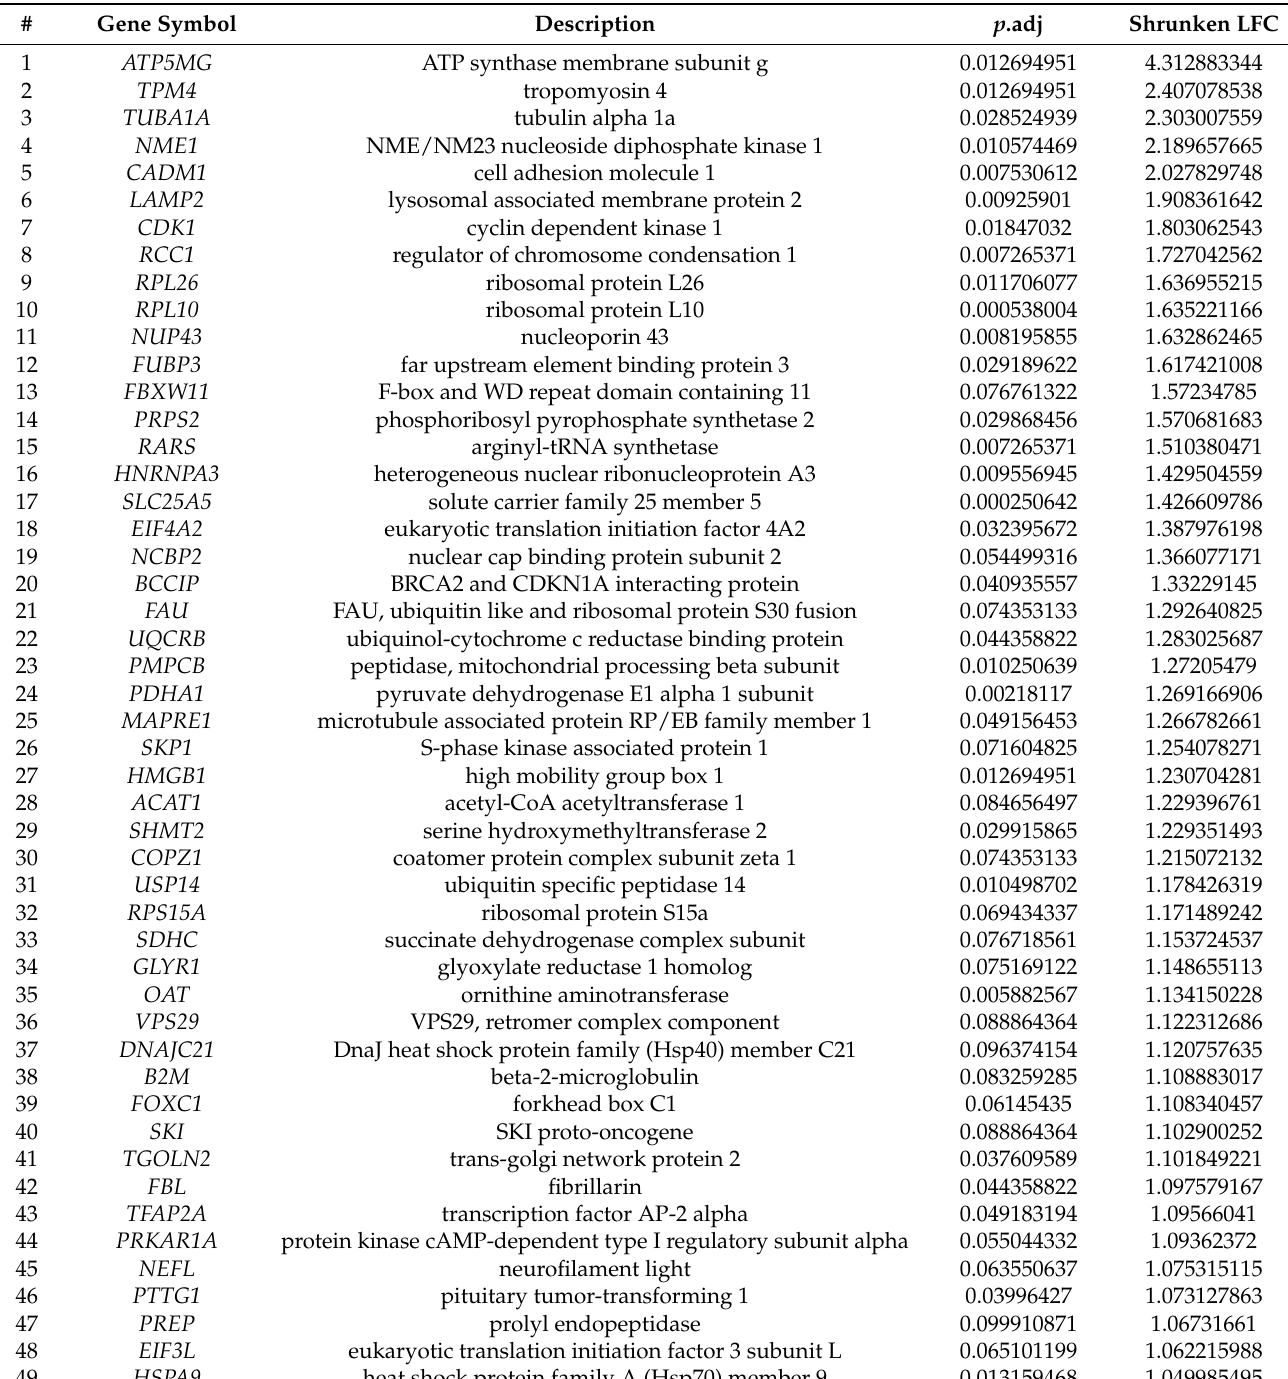
Table 1. Genes that were activated at the translational level in eL38-deficient HEK293